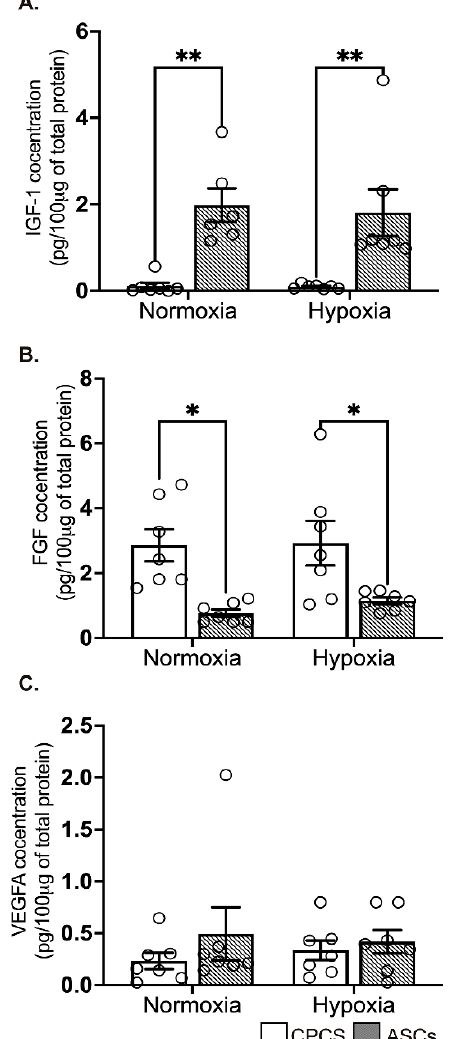
Figure 4. Secretion of paracrine factors by CPCs’ and ASCs’ quantitative scatter plot column graphs showing the level of insulin growth factor-1 (IGF-1) ( A ), fibroblast growth factor (FGF) ( B ) and vascular endothelial cell growth factor (VEGF) ( C ) measured by ELISA in the CM collected from CPCs and ASCs cultured under normoxia and hypoxia. Data are represented as mean ± SEM (n = 6 in each group); * p < 0.05 and ** p < 0.01. All the experiments were performed in duplicates.